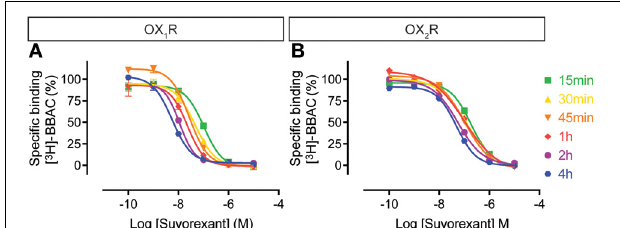
FIGURE 6 | Effect of time on suvorexant competition for [ 3 H]-BBAC ((S)-N-([1,1 (cid:2) -biphenyl]-2-yl)-1-(2-((1-methyl-1H-benzo[d]imidazol-2- yl)thio)acetyl)pyrrolidine-2-carboxamide) binding to membranes from CHO cells expressing human (A) OX 1 R or (B) OX 2 R. Data is representative of triplicate determinations and error bars indicate s.e.m.